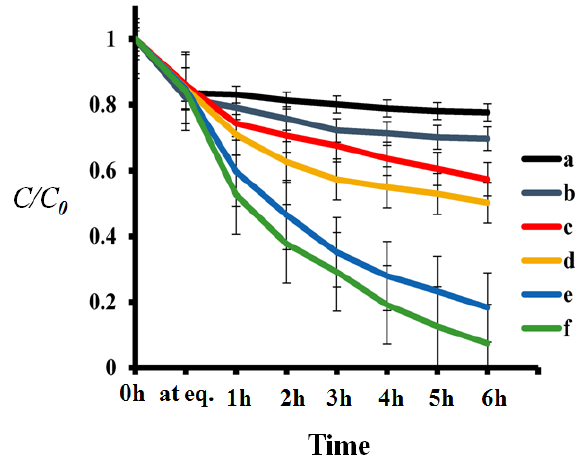
Figure 6. The degradation of the RhB for TiO 2 -coated and dye/TiO 2 -coated cotton fabrics: ( a ) Control dye solution; ( b ) TiO 2 -coated cotton fabric. While ( c ), ( d ), ( e ) and ( f ) are dye/TiO 2 -coated cotton fabrics with a dye concentration of 0.16, 0.08, 0.016 and 0.01 mg/L, respectively.